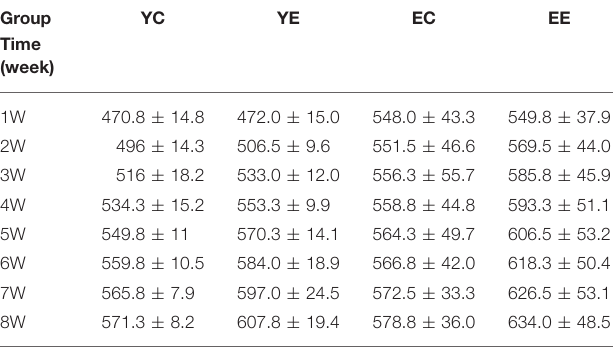
TABLE 2 | Changes in body weight (g) of rats in each group ( n = 10, ± s). Group Time